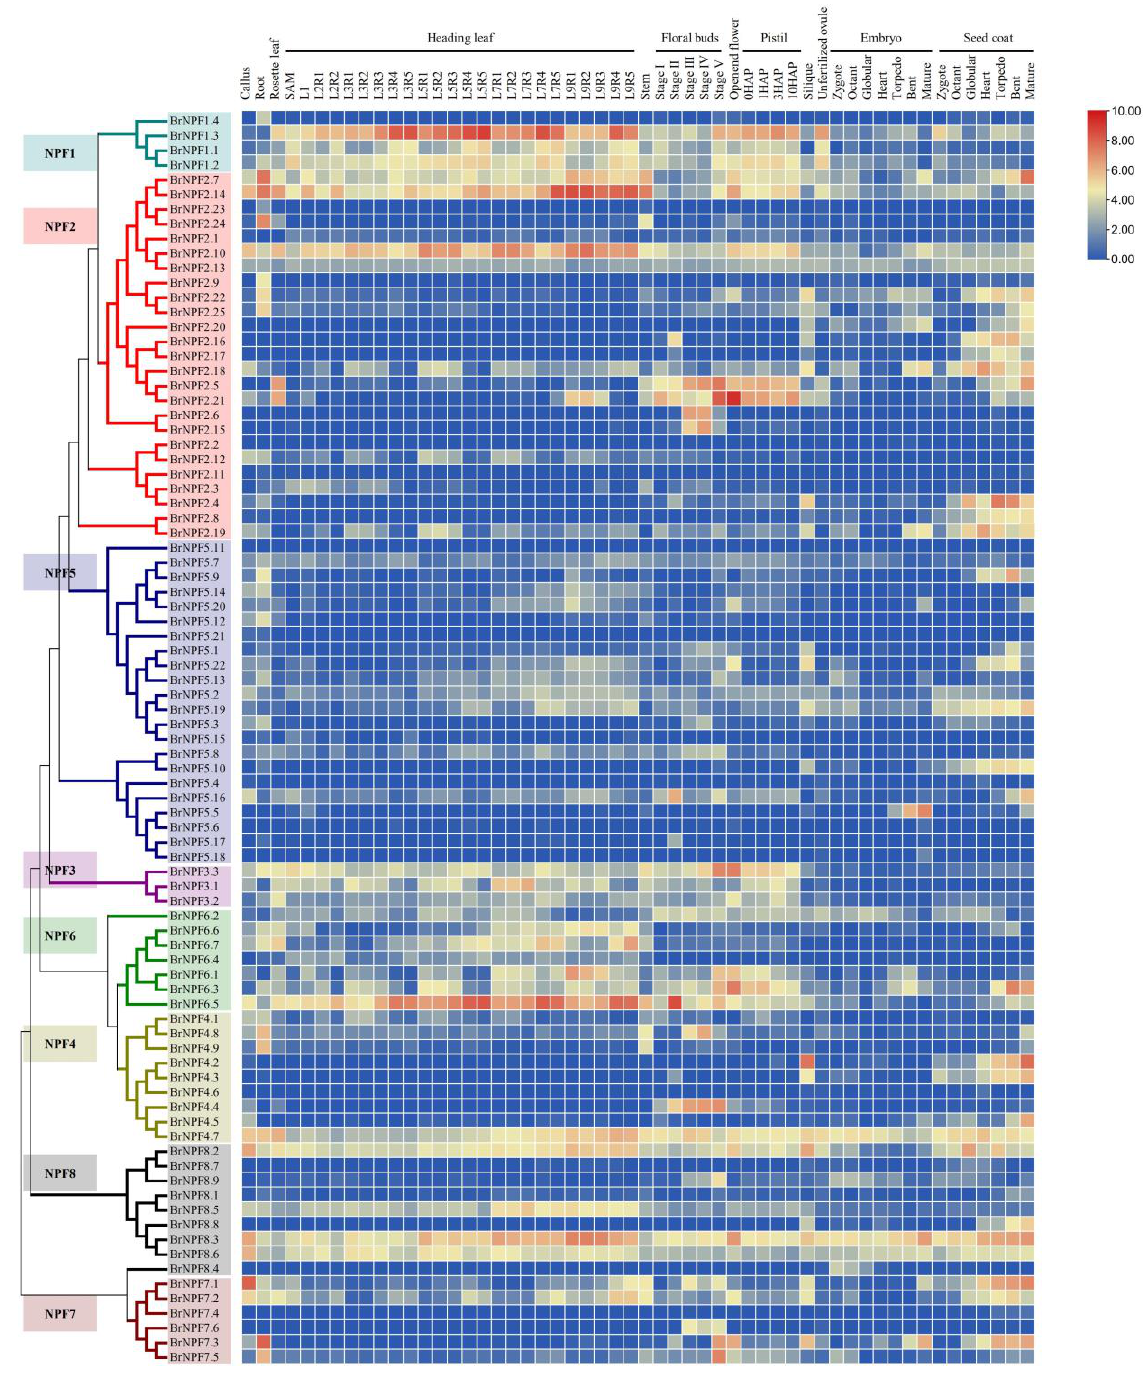
Figure 4. Expression of BrNPFs in different tissues and organs of Brassica rapa . Expression data were subjected to log 2 (TPM+1) normalization. Comparisons of stem leaf, stem, and root tissues were conducted by comparison against seven-week-old Chiifu ( B. rapa cv. Chiifu) plants. Flower tissue was also generated from blooming plants without floral shoots, while silique tissues were obtained 15 days after pollination. Further, 24 samples from the heading leaves of eleven-week-old plants were collected. All leaves from the heading leaf samples were divided into eleven whorls extending from the inside to the outside. Leaves with a length < 2 cm and shoot apical meristem (SAM) are identified as SAMs. Leaves from whorls one, two, three, five, seven, and nine were identified as L1, L2, L3, L5, L7, and L9, respectively. L2 samples were divided into leaf petiole (L2R2) and leaf blade (L2R1) samples, while L3, L5, L7, and L9 were divided into regions including the top region (R1), outer margin region (R2), the middle region of the blade (R3), top region of the petiole (R4), and middle region of the petiole (R5). FS1-5 and SS1- 5 indicate the floral buds from the ‘Bcajh97 - 01A/B’ GMS